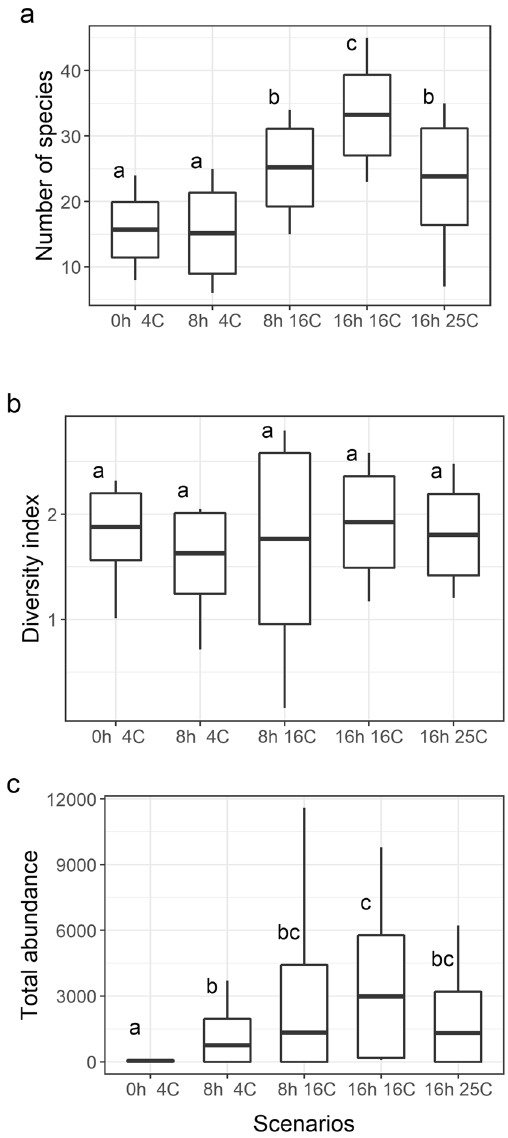
Figure 1. Differences in ( a ) species richness, ( b ) Shannon–Weaver diversity index values, and ( c ) total abundance between the five climate scenarios (whiskers: minimum and maximum values, box: standard deviation, and line: mean; N = 75). The same letters at the boxes denote lack of significant difference ( P ≥ 0.05) between particular groups according to a post-hoc test. The graph was created in R 4.0.4 under RStudio 1.4.1106 using the ‘ggplot2’ package and the data in